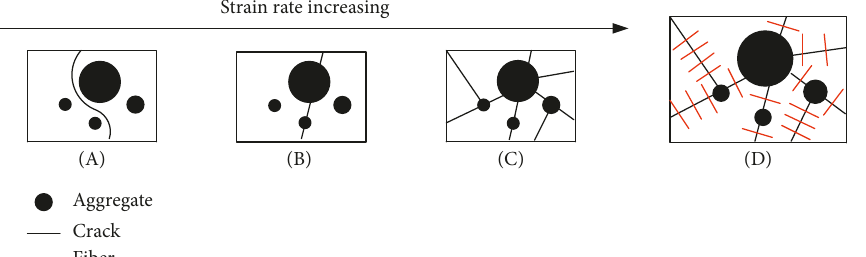
Figure 11: Schematic of the failure mode of concrete specimens and fiber cracking in concrete materials at different strain